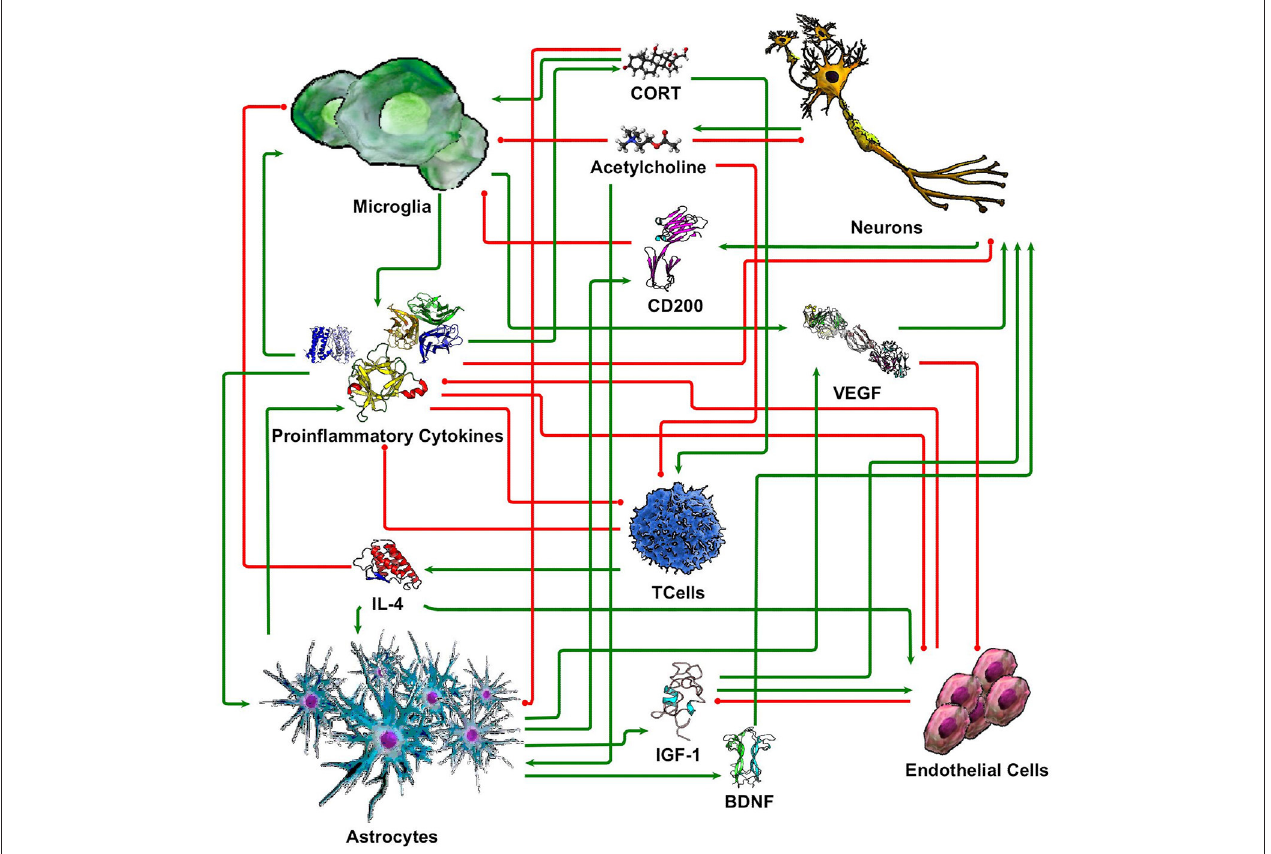
FIGURE 1 | Simple neuroimmune signaling network. Connections with green arrow terminators represent stimulatory effects while connections with red circle terminators represent inhibitory effects.